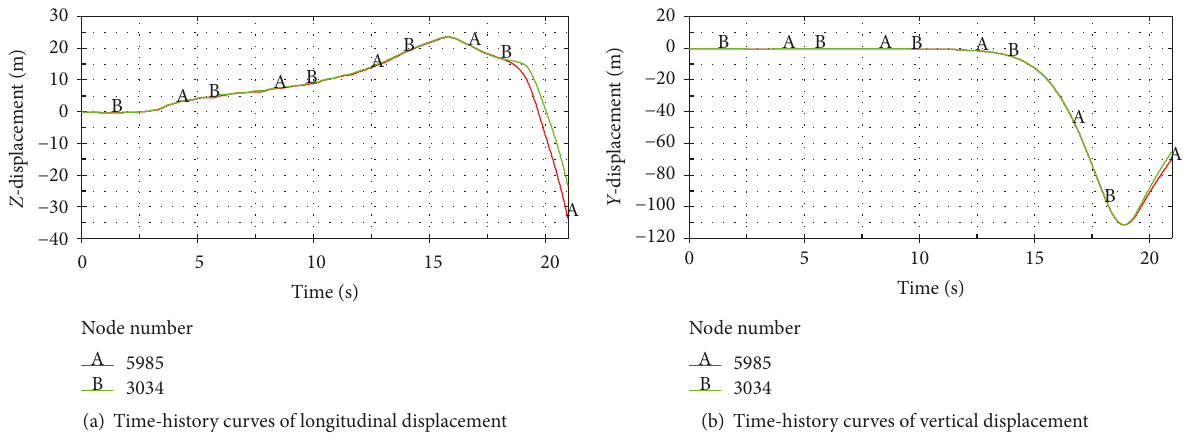
(b) Time-history curves of vertical displacement Figure 14: The displacement time-history curves of A and B nodes of girder